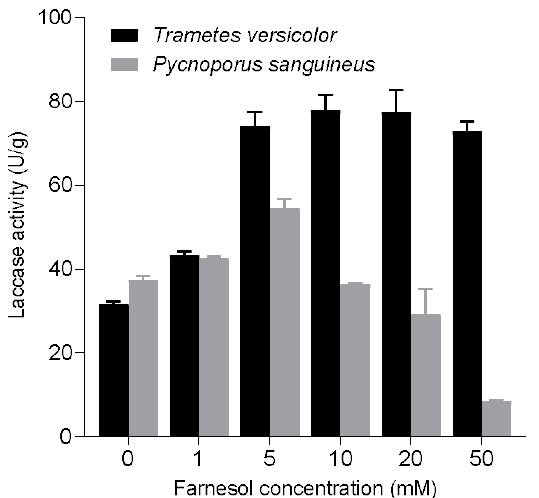
Figure 2. Effect of farnesol concentration on laccase production by T. versicolor and P. sanguineus. The cultures were developed for 7 days at 28 °C.